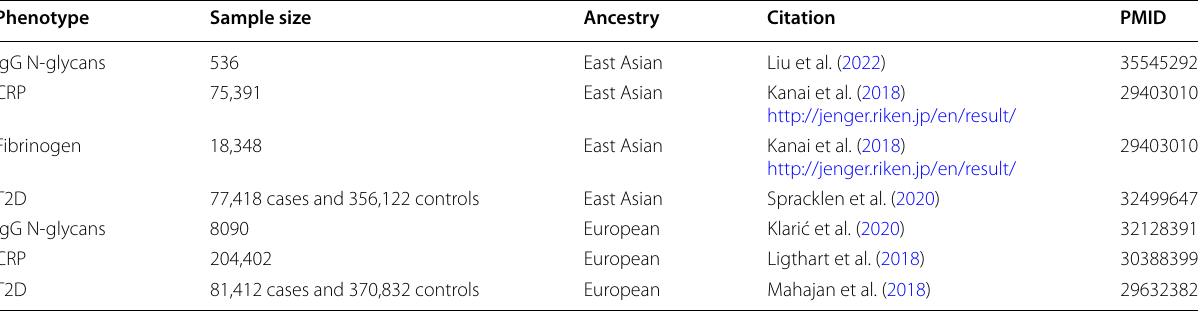
Table 1 Characteristics of the GWAS used in this